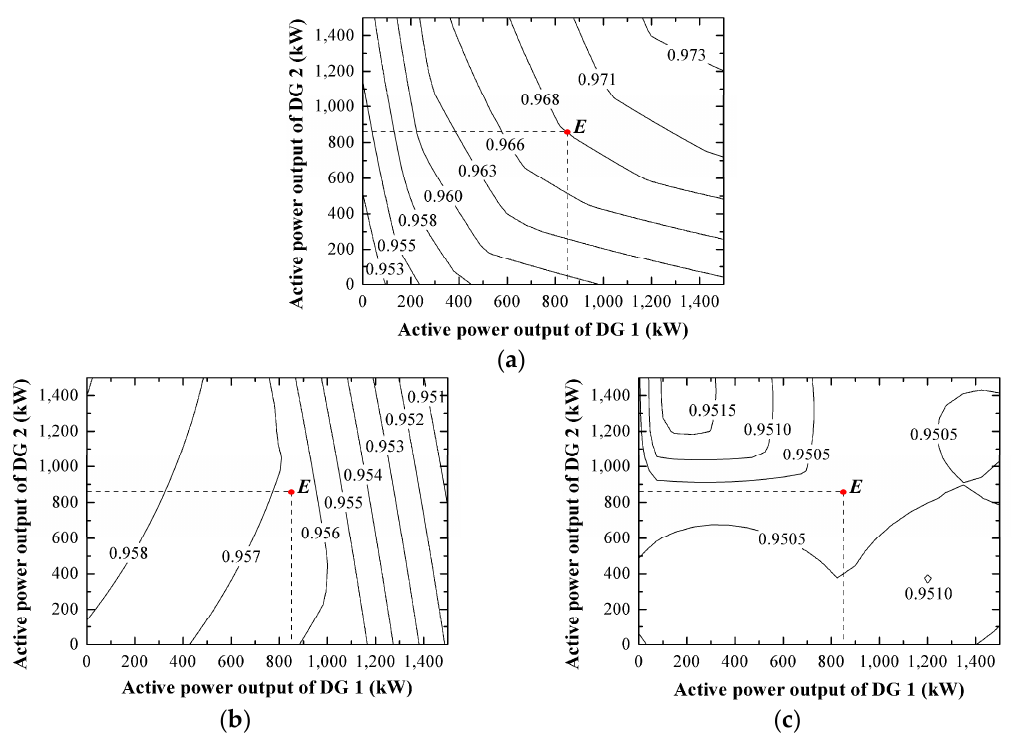
Figure 11. Contour of the minimum voltage for Case 2: Two-DG system, ( a ) fixed reactive power control; ( b ) fixed voltage control; ( c ) Proposed control.